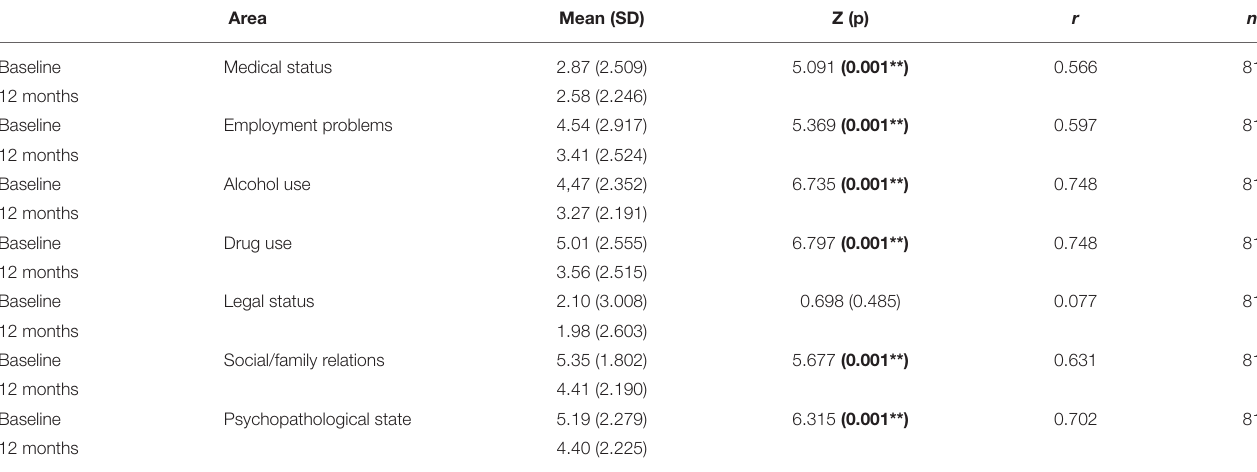
TABLE 5 | Differences between baseline and 12-month